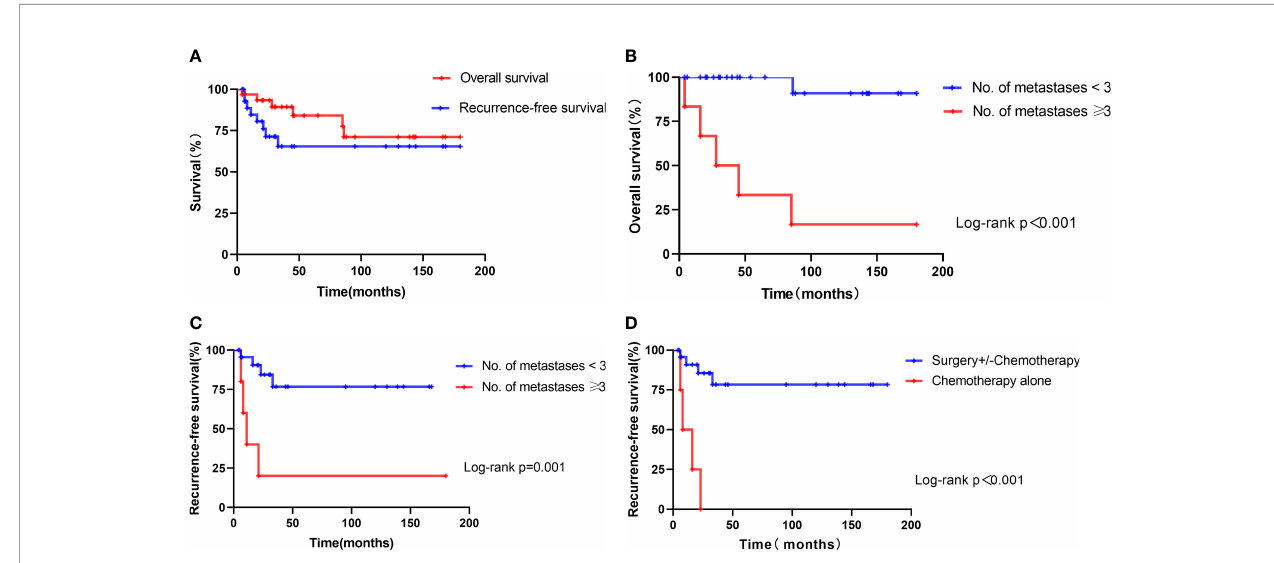
FIGURE 2 | Kaplan – Meier estimate of survival in 31 patients with ETT. (A) Overall survival and recurrence-free survival of all patients. (B) Overall survival of patients with the number of metastases ≥ 3 versus those with the number of metastases <3. (C) Recurrence-free survival of patients with the number of metastases ≥ 3 versus those with the number of metastases <3. (D) Recurrence-free survival of patients treated with chemotherapy alone versus those with